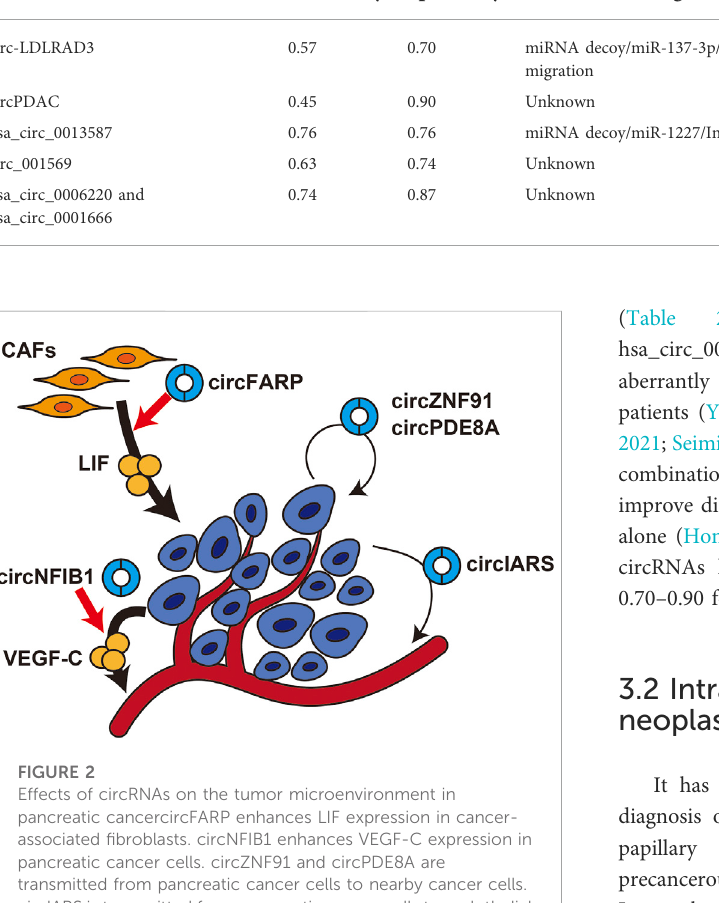
TABLE 2 CircRNAs as diagnostic biomarkers for pancreatic cancer.